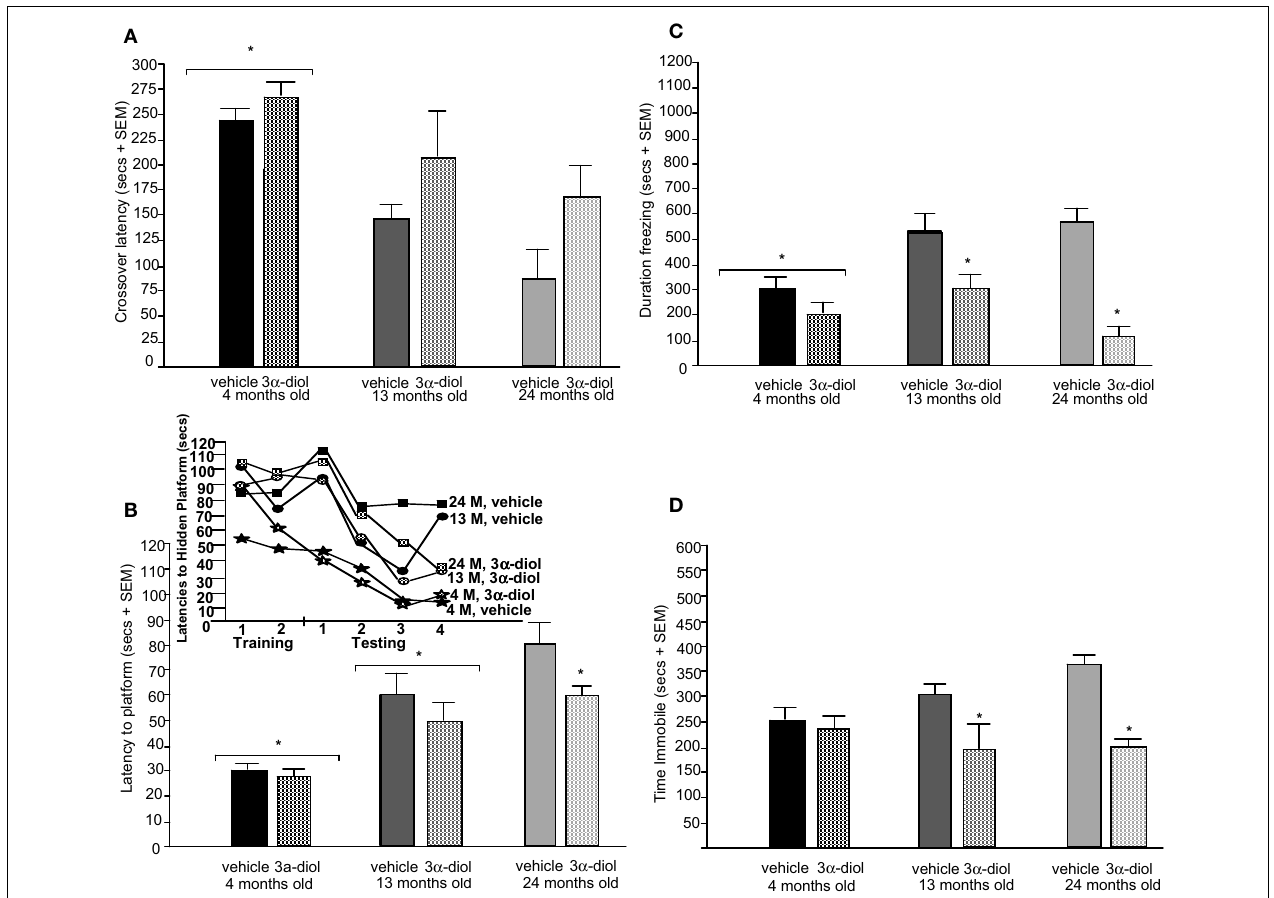
FIGURE 5 | Represents behavior of 4- (black bars), 13- (dark grey bars), and 24-(light grey bars) month-old intact rats administered subcutaneous injections of sesame oil vehicle (solid bars) or 3 α -diol (checkered bars) in the inhibitory avoidance task (A), water maze (B), defensive freezing task (C), and